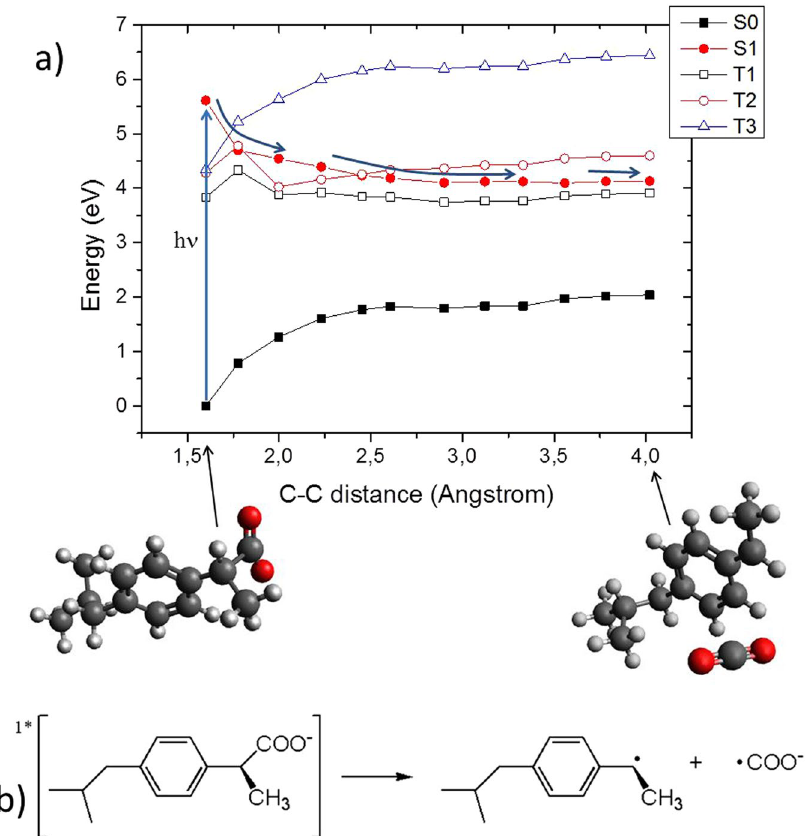
Figure 7. ( a ) CASPT2//CASSCF MEP of ibuprofen in the S 1 state, shown as a function of the photo- dissociation coordinate. TD-DFT and CAS-SCF results are provided in Supplementary Information and give the same global picture. b) Reactants and products are displayed, including the chemical